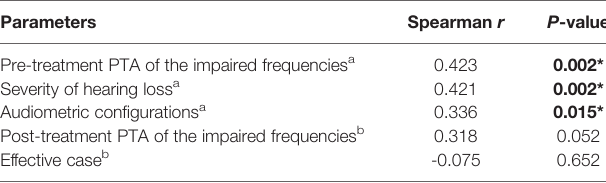
TABLE 4 | Correlation between the HbA1c level and SSNHL.